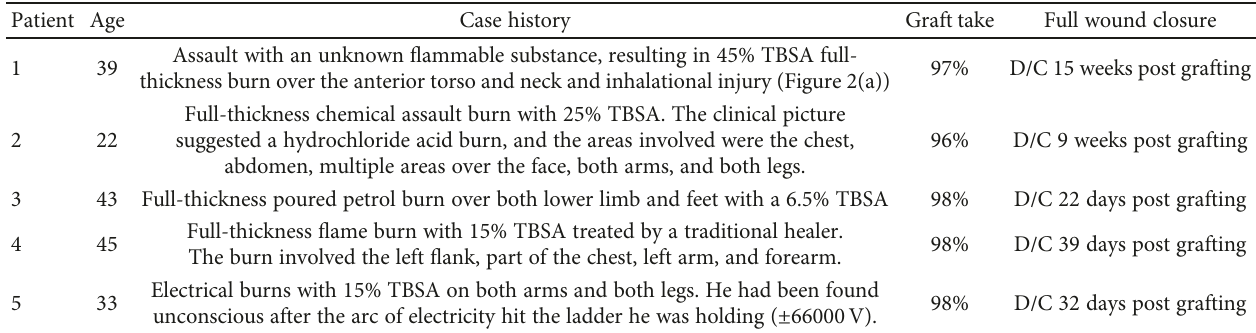
Figure 3: Representative images for patient 3. (a) Chronic burn wound with failed graft, overgranulation, and in fl ammatory margins. (b) Day 4 post widely meshed graft and PRF/spray-on skin where the wound is already reepithelialized. Table 2: Clinical